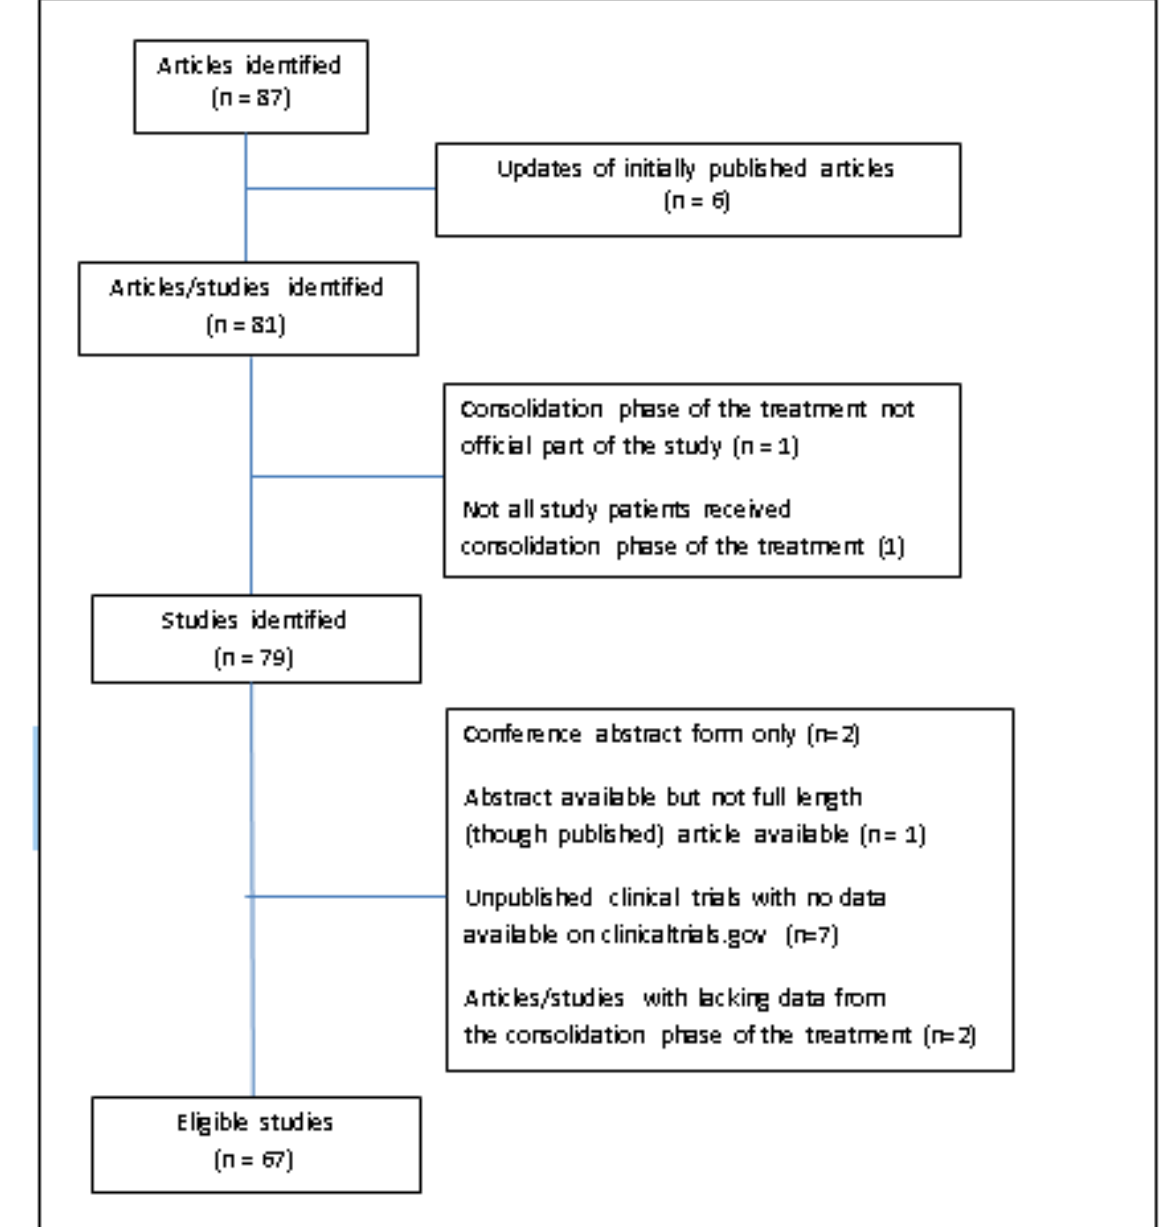
Figure 1. Flow chart of the search process with 67 eligible and 20 ineligible Figure 1. –Flow chart of the search process with 67 eligible and 20 ineligible records.